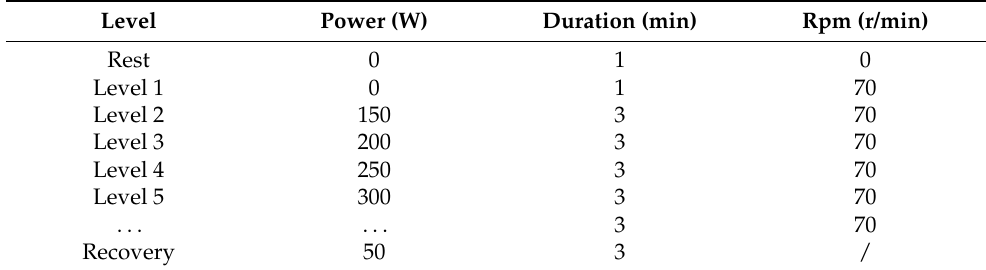
Table 4. The Cycling Incremental Load Scheme.